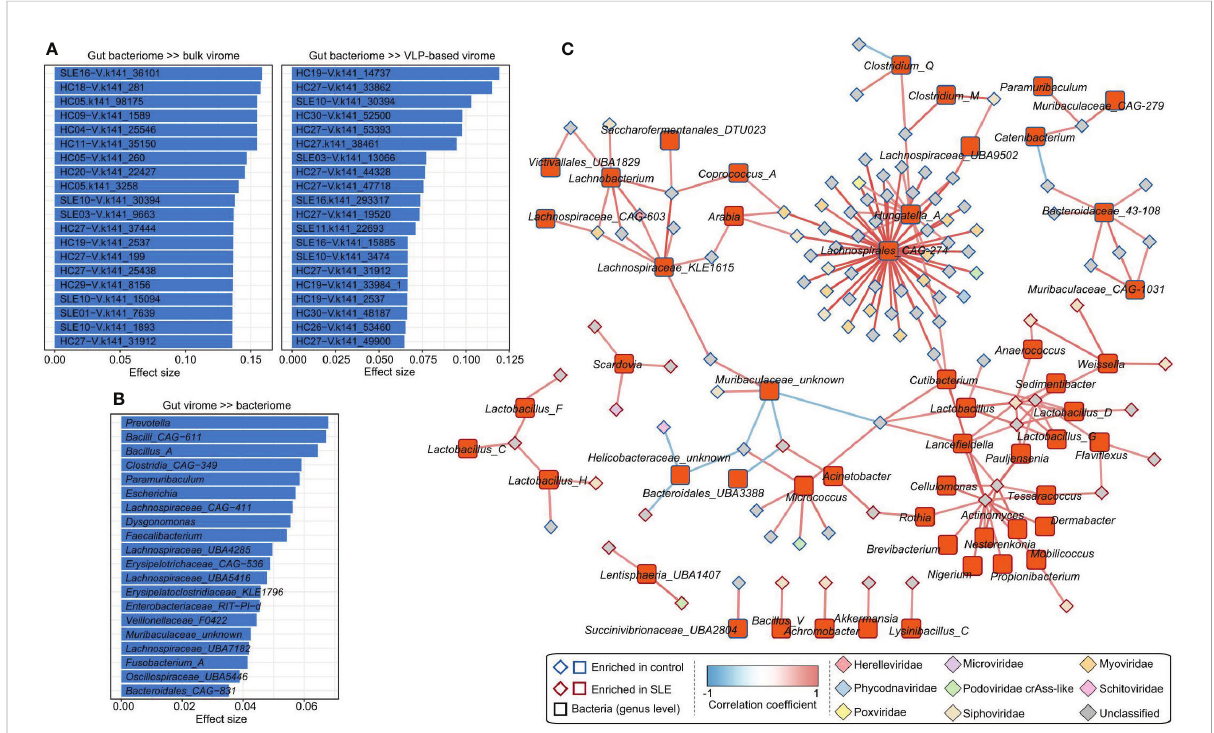
FIGURE 4 Associations between gut virome and bacterial microbiome. (A) The vOTUs with the highest effect size are signi fi cantly impacted by the gut bacteriome. The top 20 vOTUs from the bulk metagenomic dataset (left panel) and the top 20 vOTUs from the VLP-based virome dataset (right panel) are shown. (B) The top 20 bacterial genera for which the highest effect size has a signi fi cant impact on the gut virome. (C) The correlation network between SLE-associated vOTUs and bacterial genera. The network was constructed based on Spearman correlations ( r > 0.6 or < -0.6, correlation test adjusted P < 0.05) between viruses and